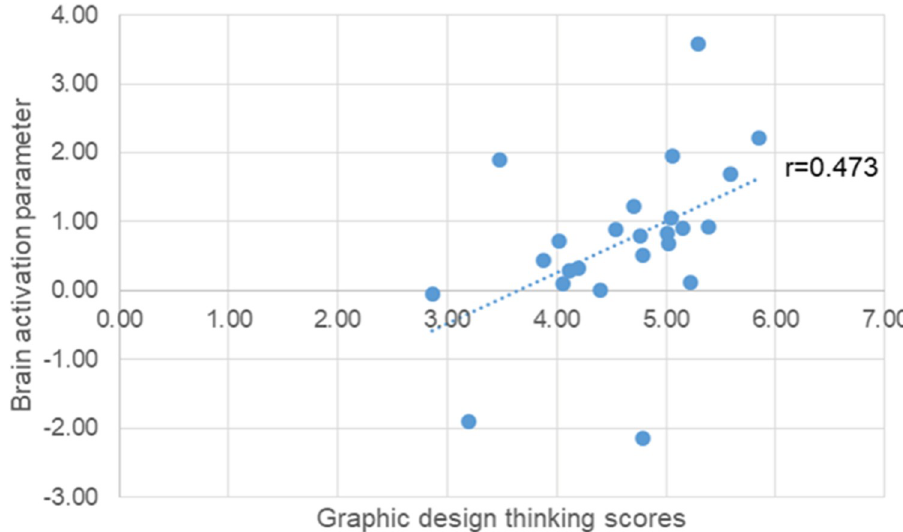
Fig 10. Correlation of brain activation parameters and refinement in graphic design thinking